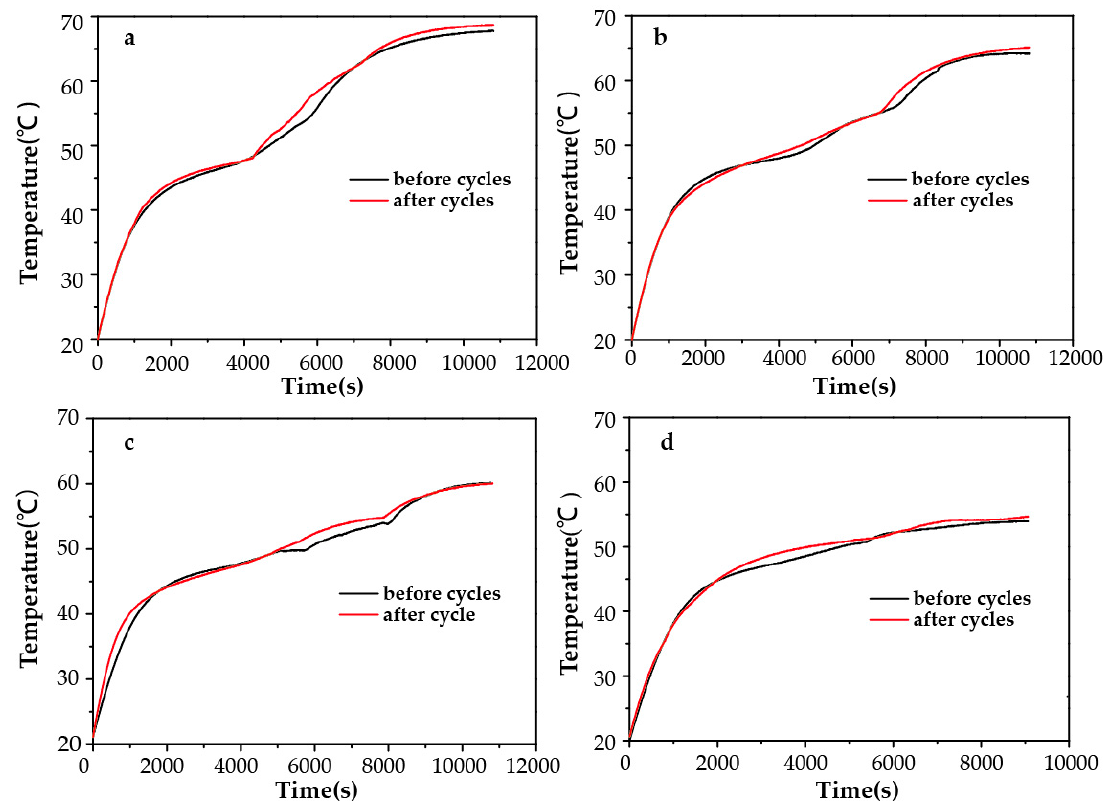
Figure 6. Photo-thermal conversion before and after 20 times irradiation and cooling cycles of ( a ) TC-PCM 50 ( b ) TC-PCM 90 ( c ) TC-PCM 130 ( d ) TC-PCM 180.